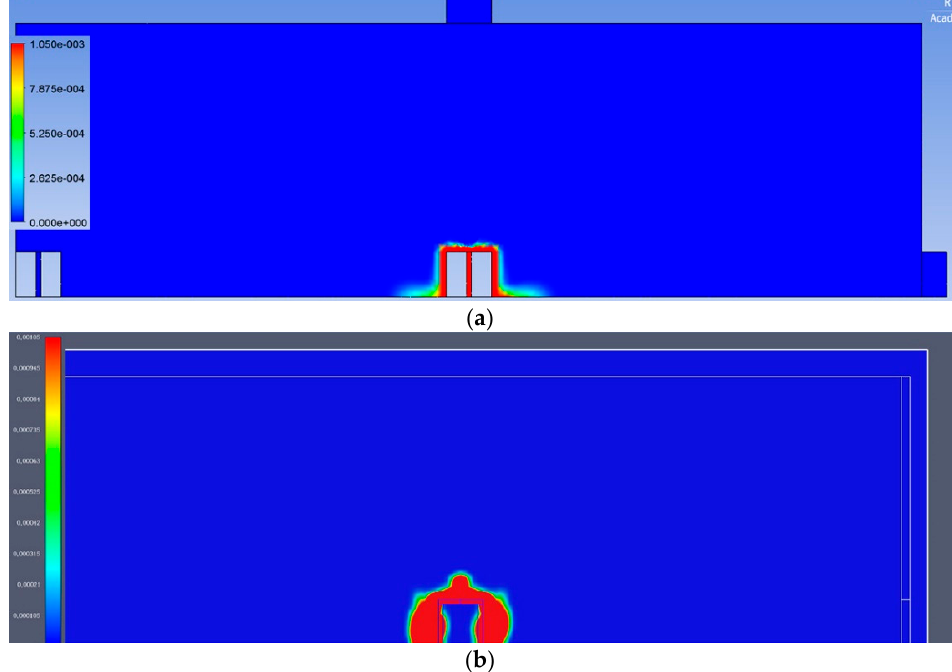
Figure 8. Comparison of propane dispersion for 5% concentration of LEL for time 25 s: ( a ) propane release calculated with Ansys software; ( b ) propane release calculated with FDS software.